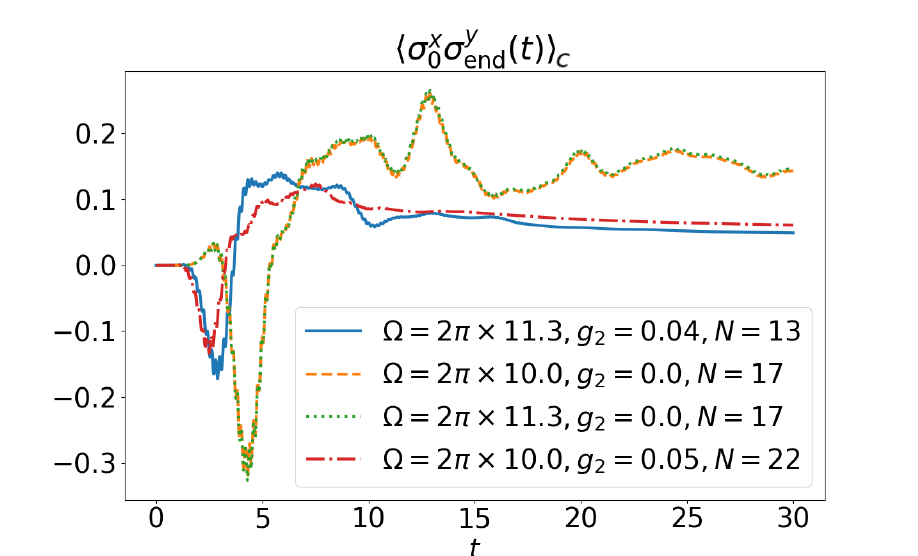
Figure 13: The two-qubit X Y connected correlation function of the two edge qubits vs. the time t . The curves with N = 13,17 correspond to a linear chain configura- tion, while N = 22 is for a plaquette topology, where the qubit frequencies alternate between nearest neighbors in both cases. The parameters are given in Eq. (37), in addition to the plot legend for each curve. The relatively large two-point correlations between the edge qubits are robust to variations in the drive amplitude and can be seen in both topologies studied in this work. For the shown (moderate) dephasing strengths, these correlations appear to remain nonnegligible, although reduced in amplitude as can be